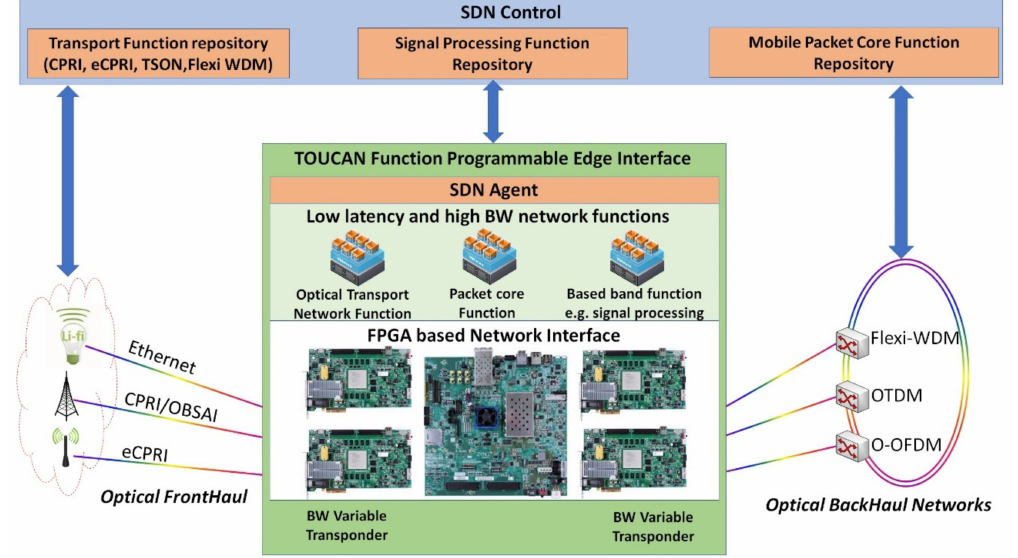
Figure 1. A high-level architecture of the Towards Ultimate Convergence of All Networks (TOUCAN) interface. SDN: software defined networking, CPRI: common public radio interface, eCPRI: evolved common public radio interface, TSON: time shared optical network, Flexi WDM: flexi-wavelength division multiplexing, BW: bandwidth, OBSAI: open base station architecture initiative, OTDM: optical time domain multiplexing, O-OFDM: optical orthogonal frequency-division